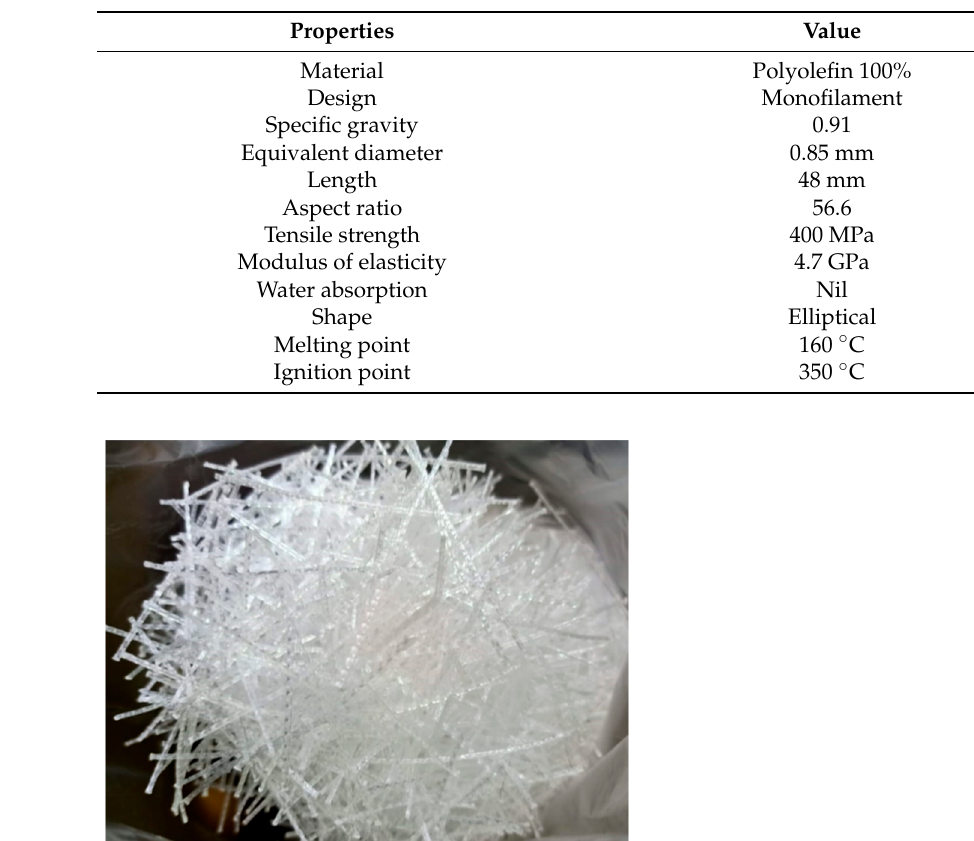
Table 3. Properties of structural macro synthetic polypropylene fibers.